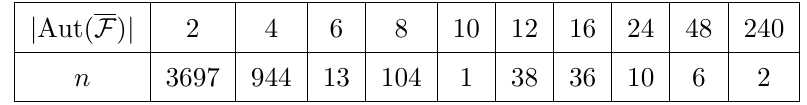
Table 3. The number of non-isomorphic one-factorizations n with j Aut( F ) j = 2 for each automor- phism group